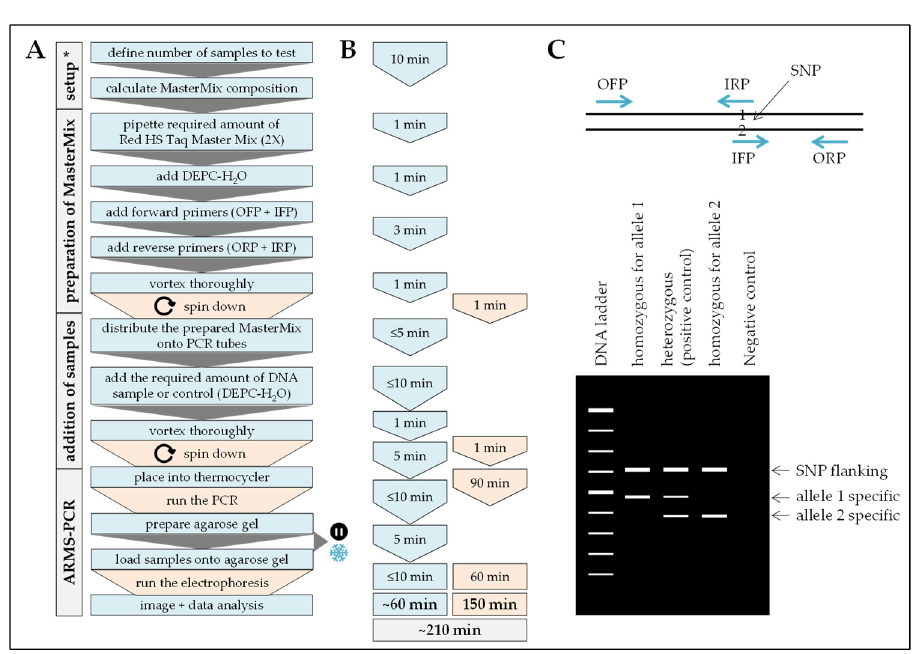
Table 2. Primer sequences used to detect SNPs of the PADI4 gene and resulting amplicon lengths. SNP